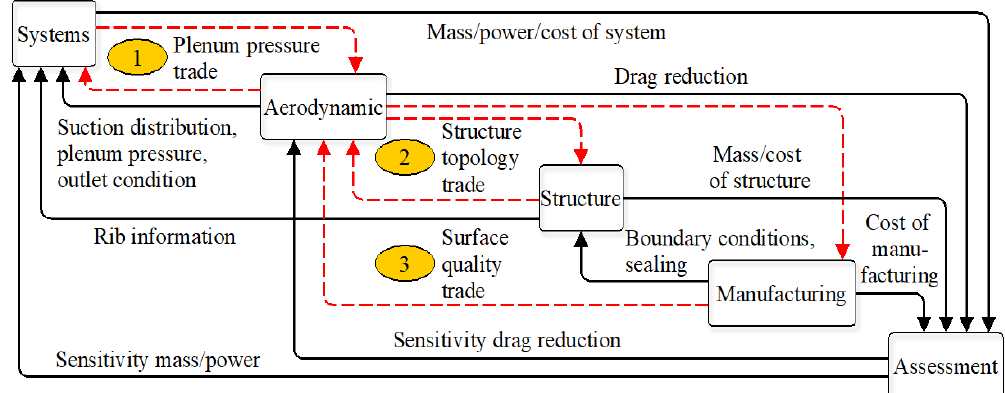
Figure 5. HLFC system interfaces between disciplines .